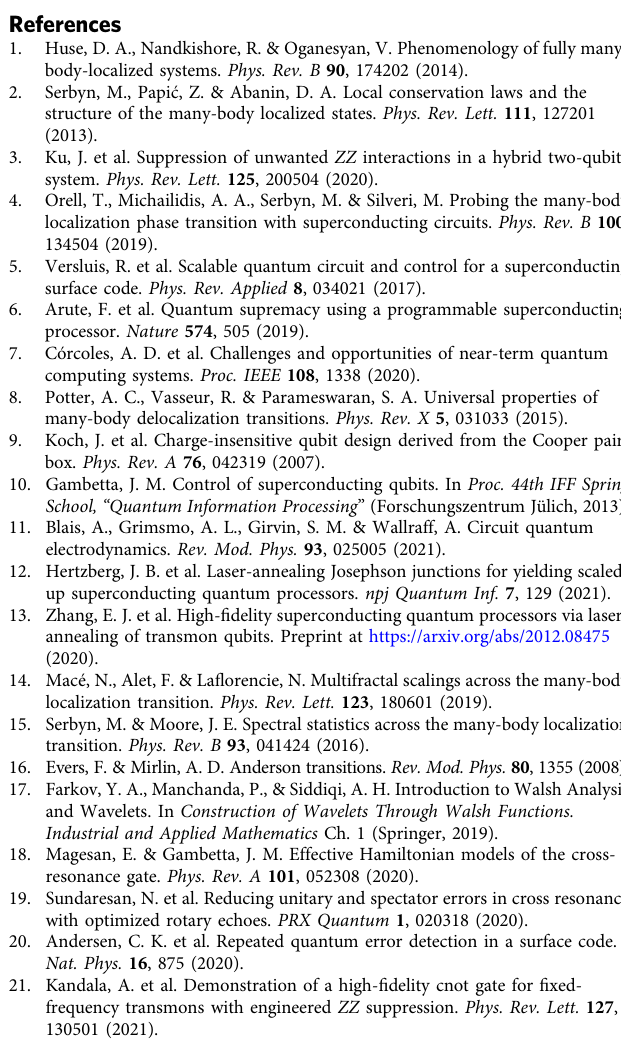
Simulation parameters . All simulation data shown in the main manuscript were calculated for E C = 0.25GHz. For scheme- A disorder, we use δν ~ E C /2, resulting in